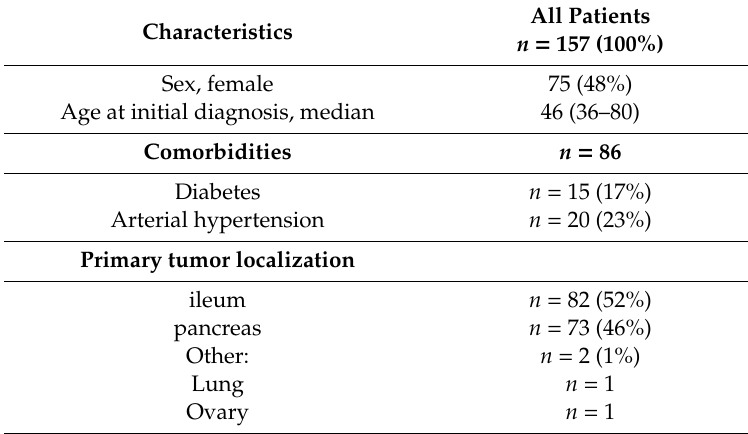
Table 1. NET patients’